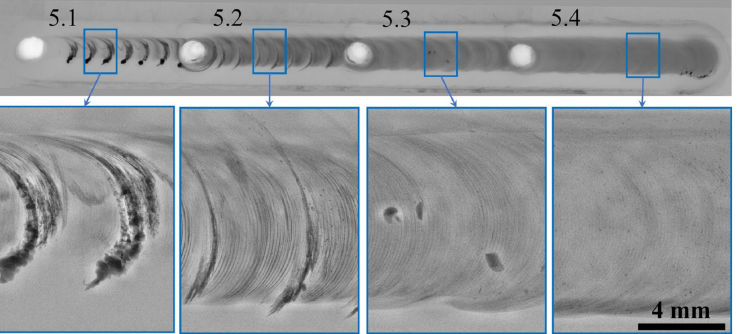
Figure 3. CT images of the processed area of Al-Mg-Sc alloy with 5 wt% Mo.